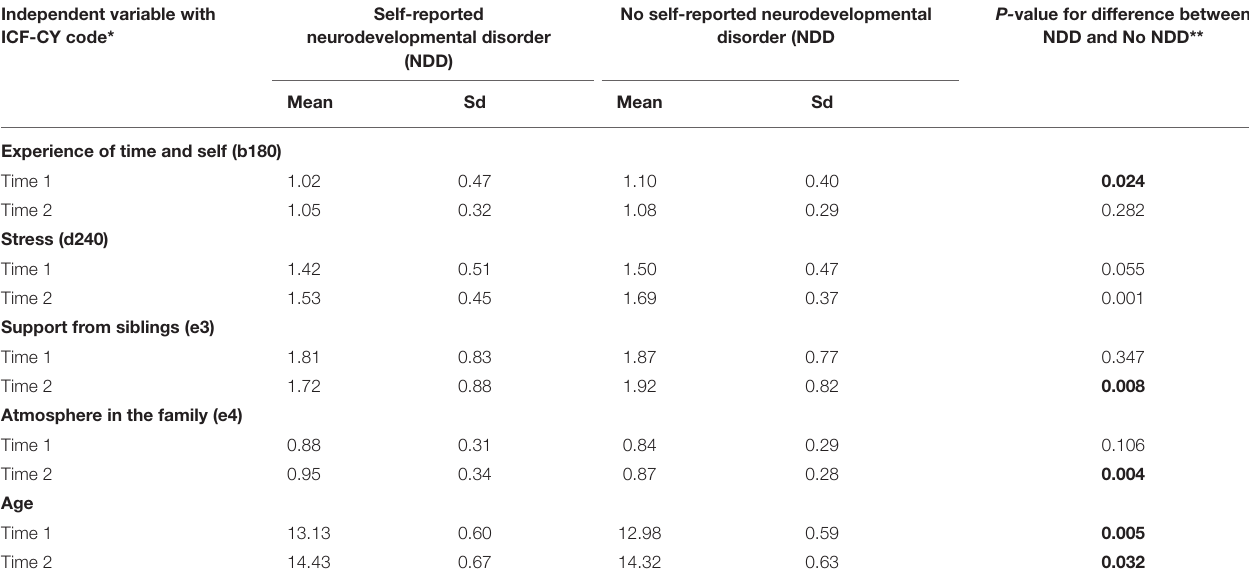
TABLE 4 | Descriptive statistics for independent variables regarding participation at home, with peers and in school. Independent variable with ICF-CY